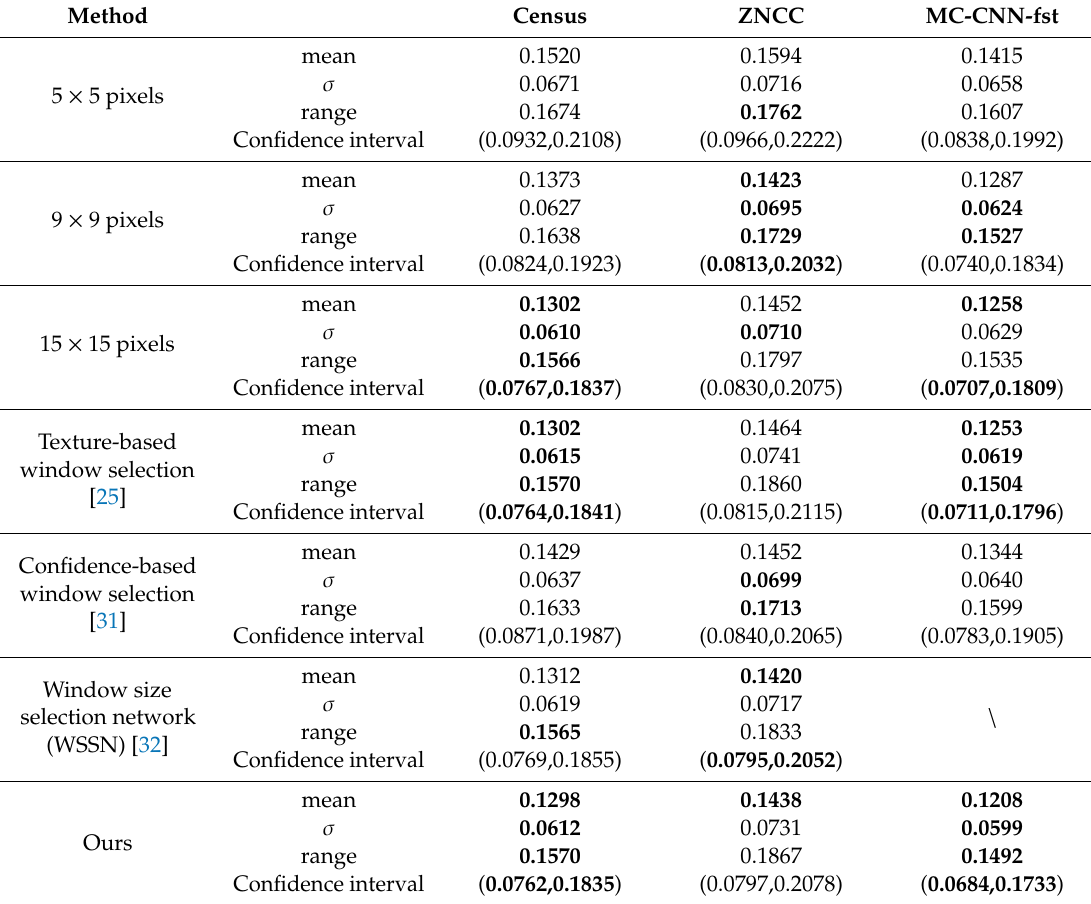
Table 3. Mismatch-3 comparison of seven di ff erent methods on the satellite dataset (bold records indicate the top-three optimal results among each of the considered statistical / matching cost